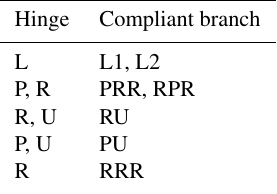
Table 3. Some types of the suitable constraint compliant